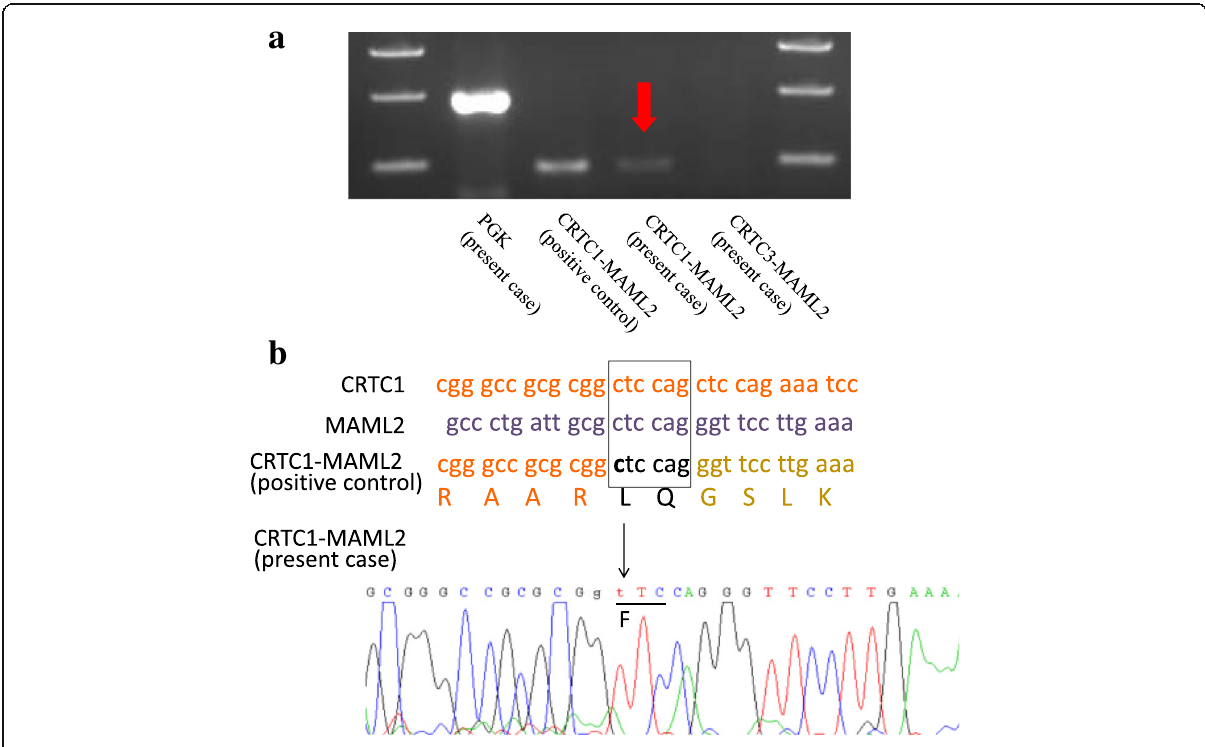
Fig. 3 Results of the CRTC1/3-MAML2 fusion gene analysis. a: The RT-PCR products which electrophoresed in 2% agarose gel showed the presence of CRTC1-MAML2 fusion ( red arrow ). b: CRTC1-MAML2 fusion was confirmed by direct